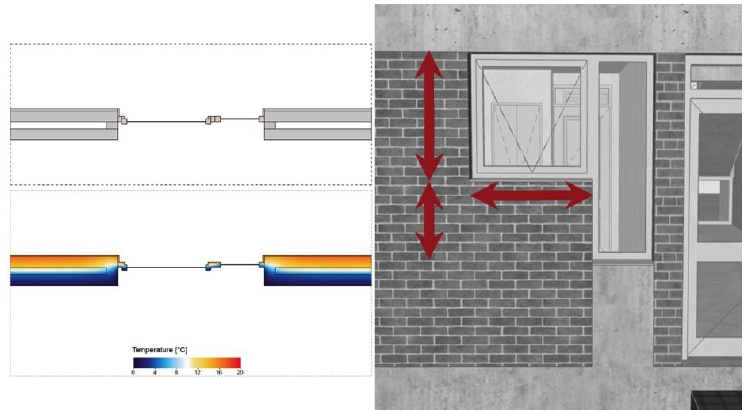
Figure 13. Output of the calculation of the thermal bridge of the window inside a fictitious wall ( left ) and dimensions considered for the length to be attributed to the thermal bridge ( right ).